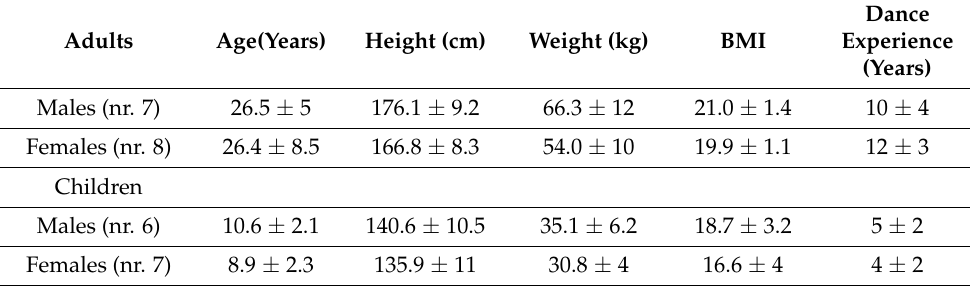
Table 1. Subjects’